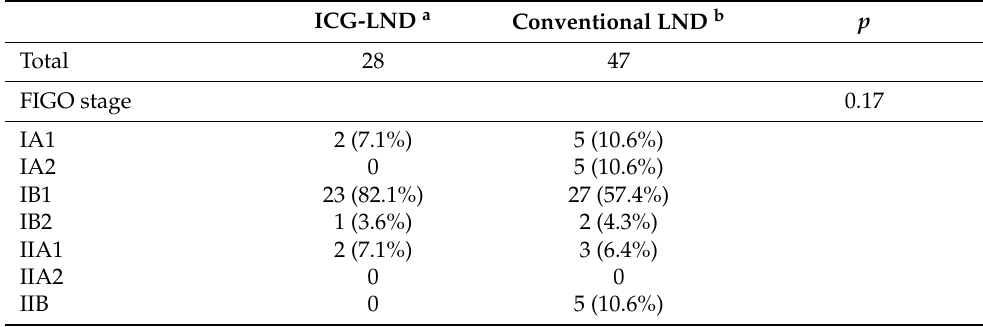
Table 3. Final stage in women affected by cervical cancer.